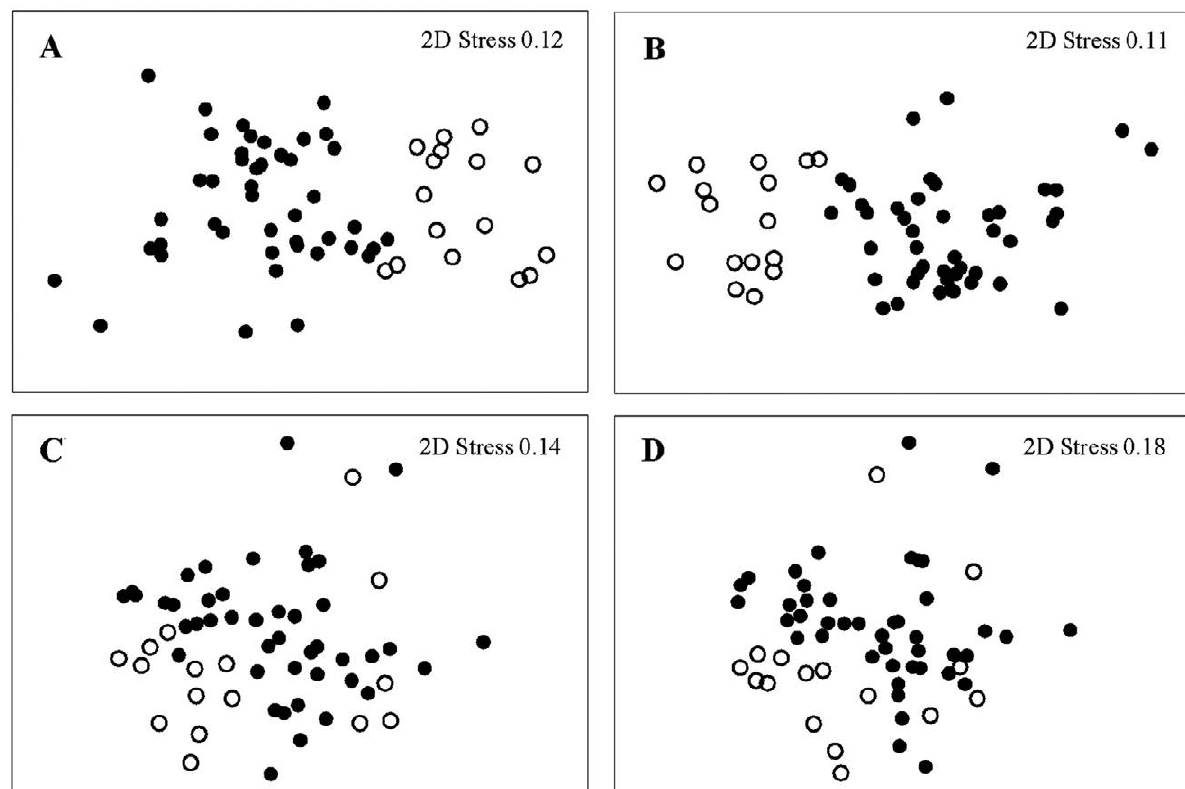
Fig. 4. – Multidimensional Scaling (MDS) ordination analysis (Bray-Curtis similarity, square root transformed) of the total catches composi- tion in abundance (A) and biomass (B) and of the bycatch composition in abundance (C) and biomass (D) using SDredge (open circles) and DDredge (full